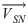
Relative velocities between two nodes moving at an angle θ.vn, velocity of the neighbor node; vs, velocity of the current sender; V→SN, relative velocity between the source and the neighbor node.